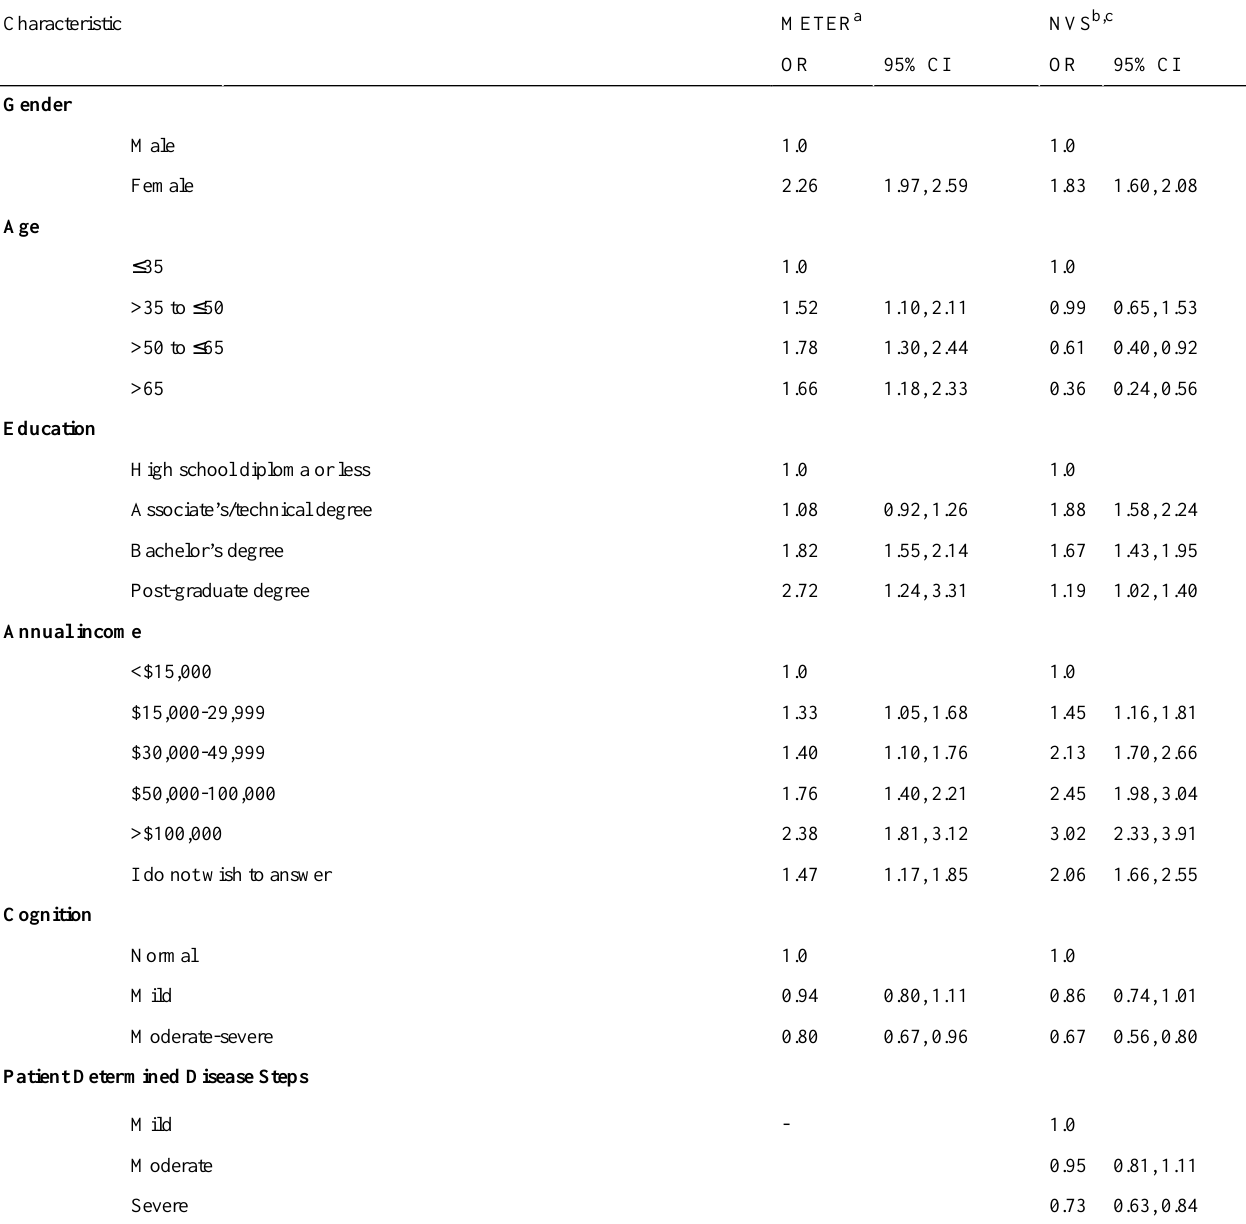
Table 4. Multivariable logistic regression: characteristics associated with functional health